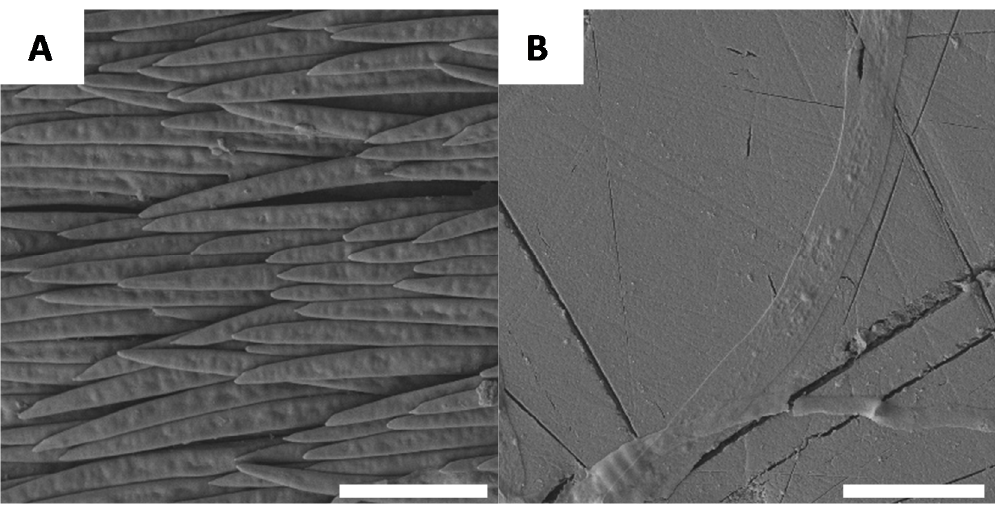
Figure 4. Example of native surfaces for G. orientalis , white ( A ) and black ( B ) part (Scale bar = 10 µm).